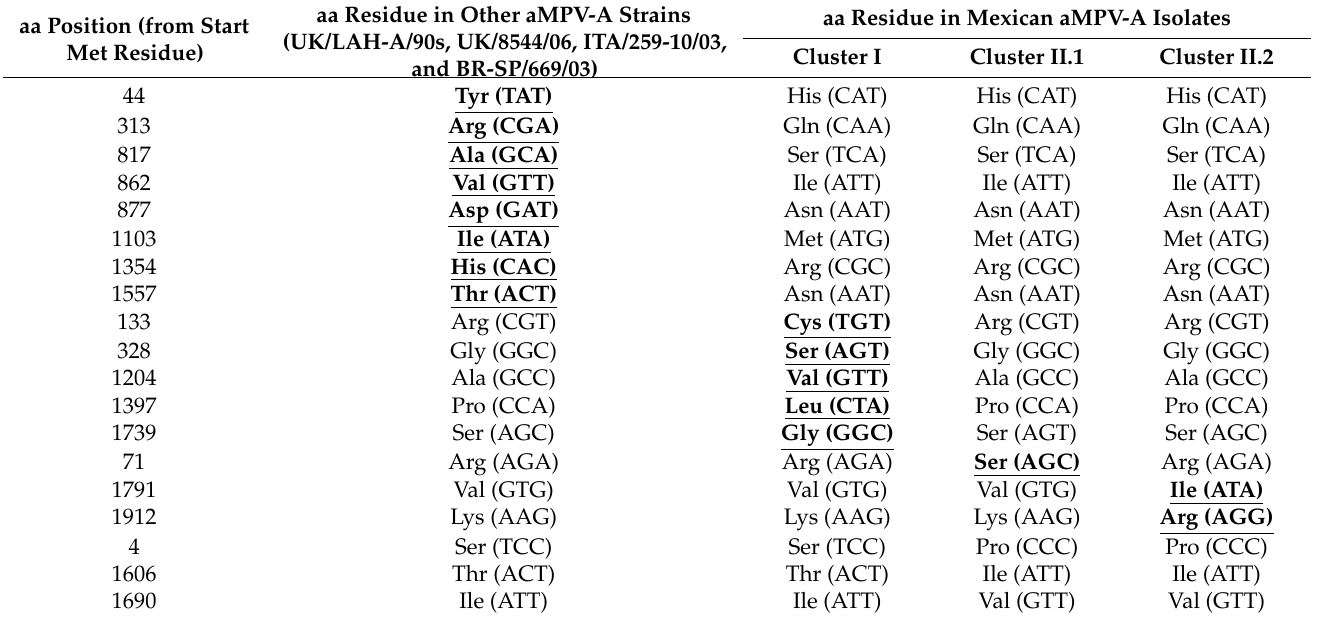
Table 3. A summary of 19 aa variations found in the L-protein sequences of the Mexican aMPV-A isolates identified in this study compared to other aMPV-A viruses, which are grouped into five categories as described in the text. The corresponding nt codons are indicated in brackets next to the aa residues (shown in three-letter abbreviations). The variations that are unique to either the previously published aMPV-A strains or the Mexican clusters I, II.1, and II.2 isolates are highlighted in bold font type and underlined (refer to Figure 6 for the clustering of the Mexican